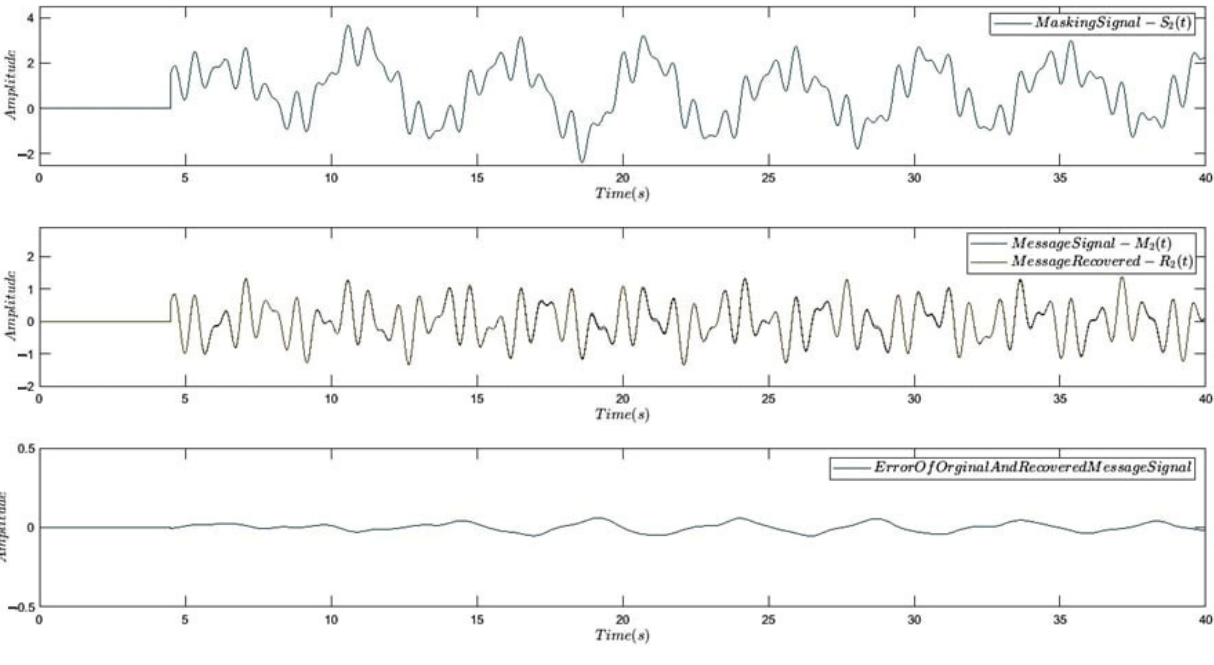
Figure 9. Message 1, masked and retrieved, and the error between these two signals.